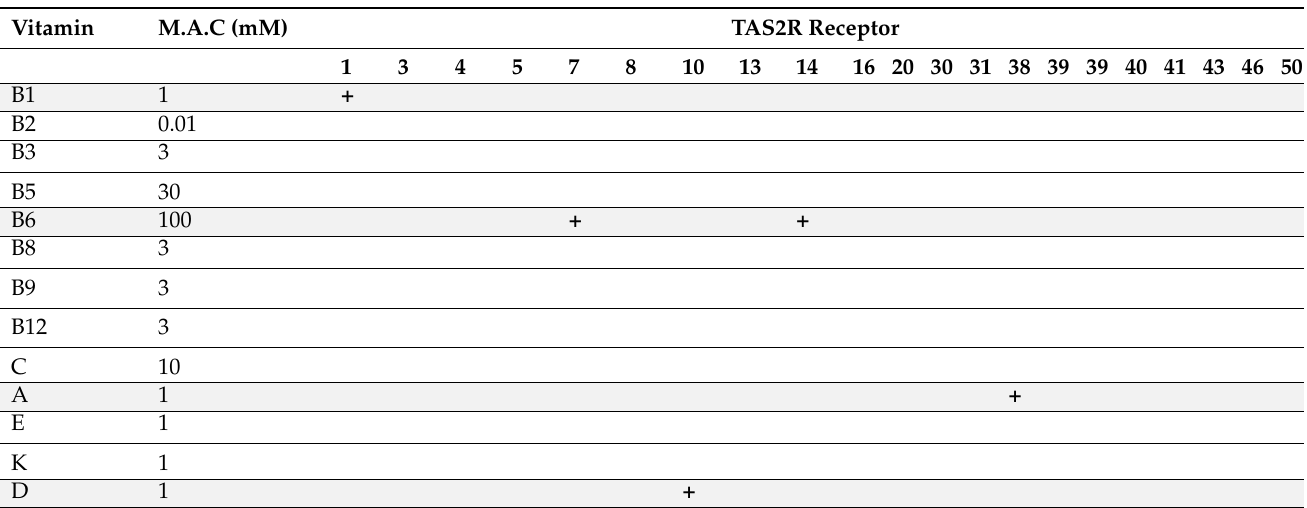
Table 2. Response profiles for 25 TAS2Rs stimulated with 13 vitamins and their maximal